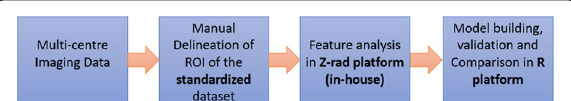
Fig. 5 Workflow PET radiomics model for prediction of event-free survival in locally advanced NSCLC using multicentre datasets